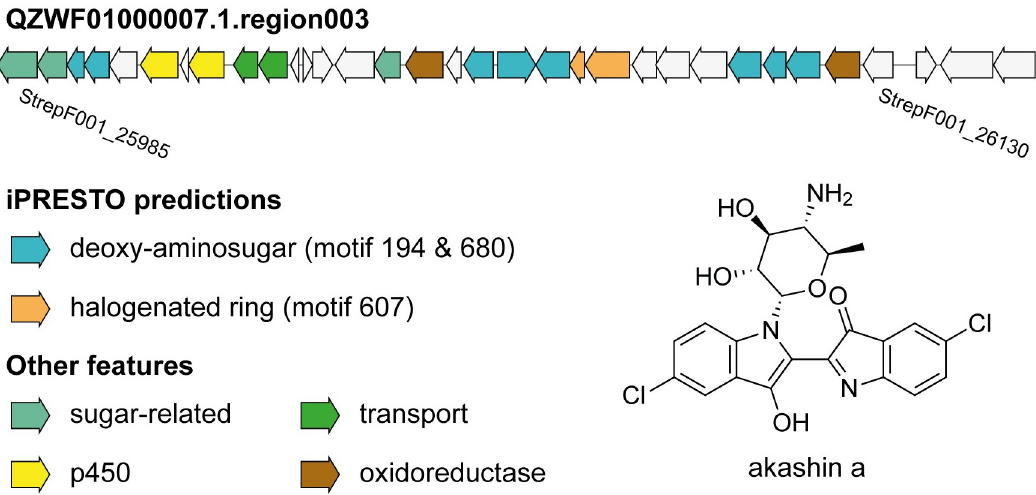
Fig 5. Putative BGC for akashin A biosynthesis. The antiSMASH-predicted BGC QZWF01000007.1.region003 is shown (StrepF001_26130-StrepF001_26145), which is hypothetically responsible for akashin A biosynthesis in S . sp. F001. Genes are coloured by their iPRESTO-predicted sub-clusters or predicted function based on Pfam